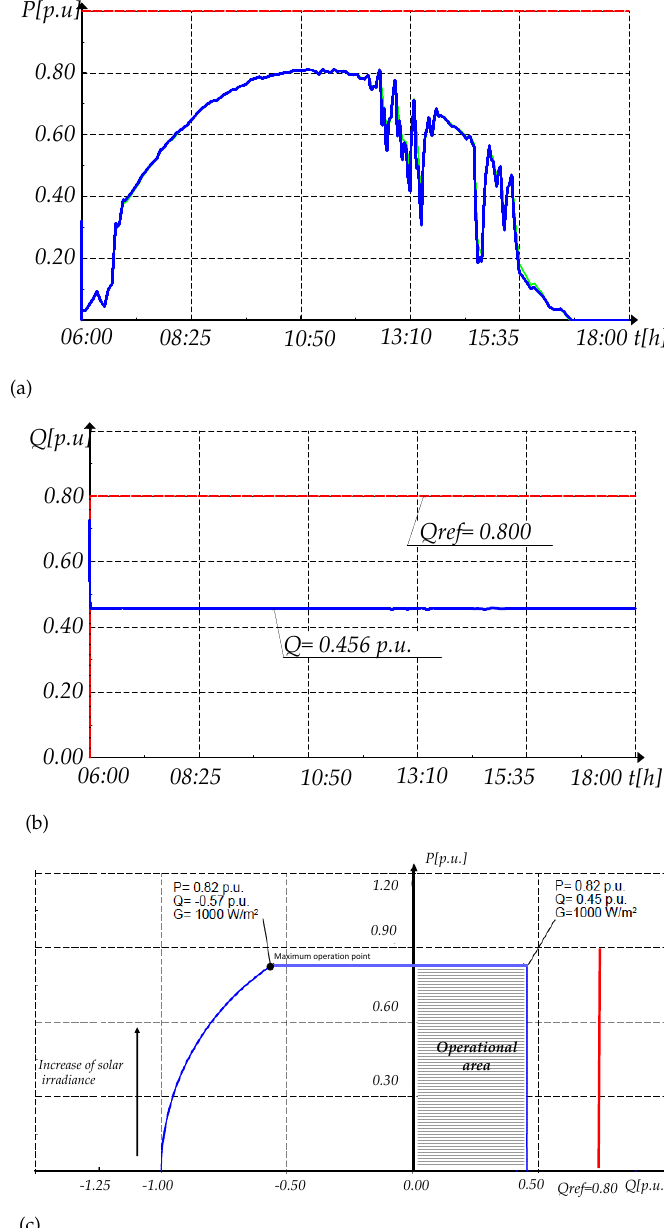
Figure 28. Power response with QPPT for M = 1 ( a ) Active power and ( b ) Reactive power, and ( c ) Operational